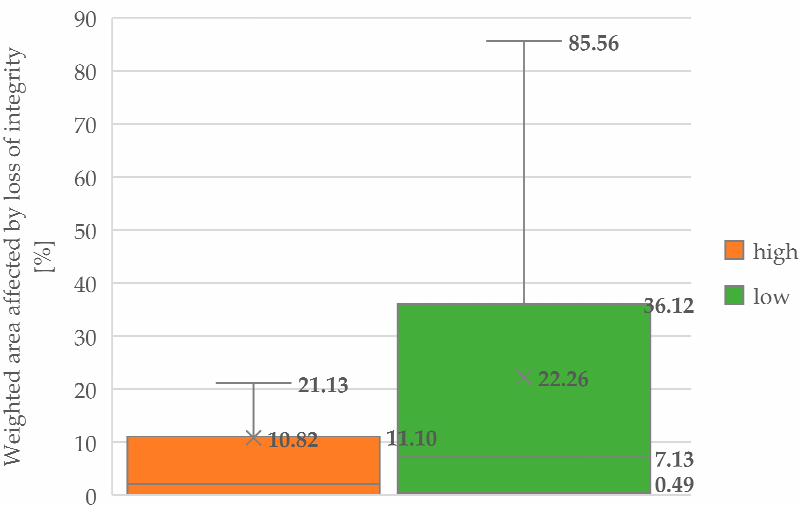
Figure 5. Boxplots of the weighted area of the façade affected by loss of integrity according to the buildings’ height.